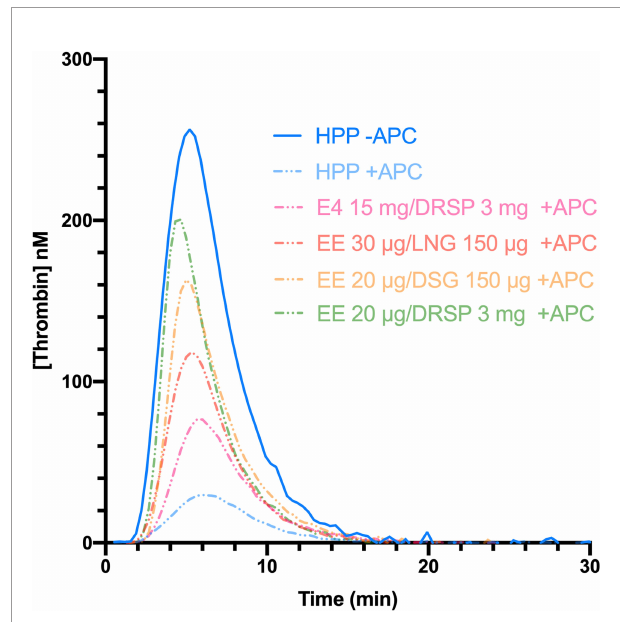
FIGURE 4 | Thrombin generation curves in absence (continuous line) and in presence of APC (dotted lines) of a healthy pooled plasma (blue) and women using combined oral contraceptives containing either ethinylestradiol (EE) with drospirenone (green), EE with desogestrel (yellow), EE with levonorgestrel (red), or estetrol with drospirenone (pink). The area under the curve represents the endogenous thrombin potential (ETP) parameter. In presence of APC, the ETP is higher with the use of combined oral contraceptives (e.g., drospirenone or desogestrel) compared to the healthy pooled plasma (composed of men and women not using hormonal contraception), leading to a resistance towards the APC. APC, activated protein C; DRSP, drospirenone; DSG, desogestrel; EE, ethinylestradiol; E4, estetrol; HPP, healthy pooled plasma; LNG,